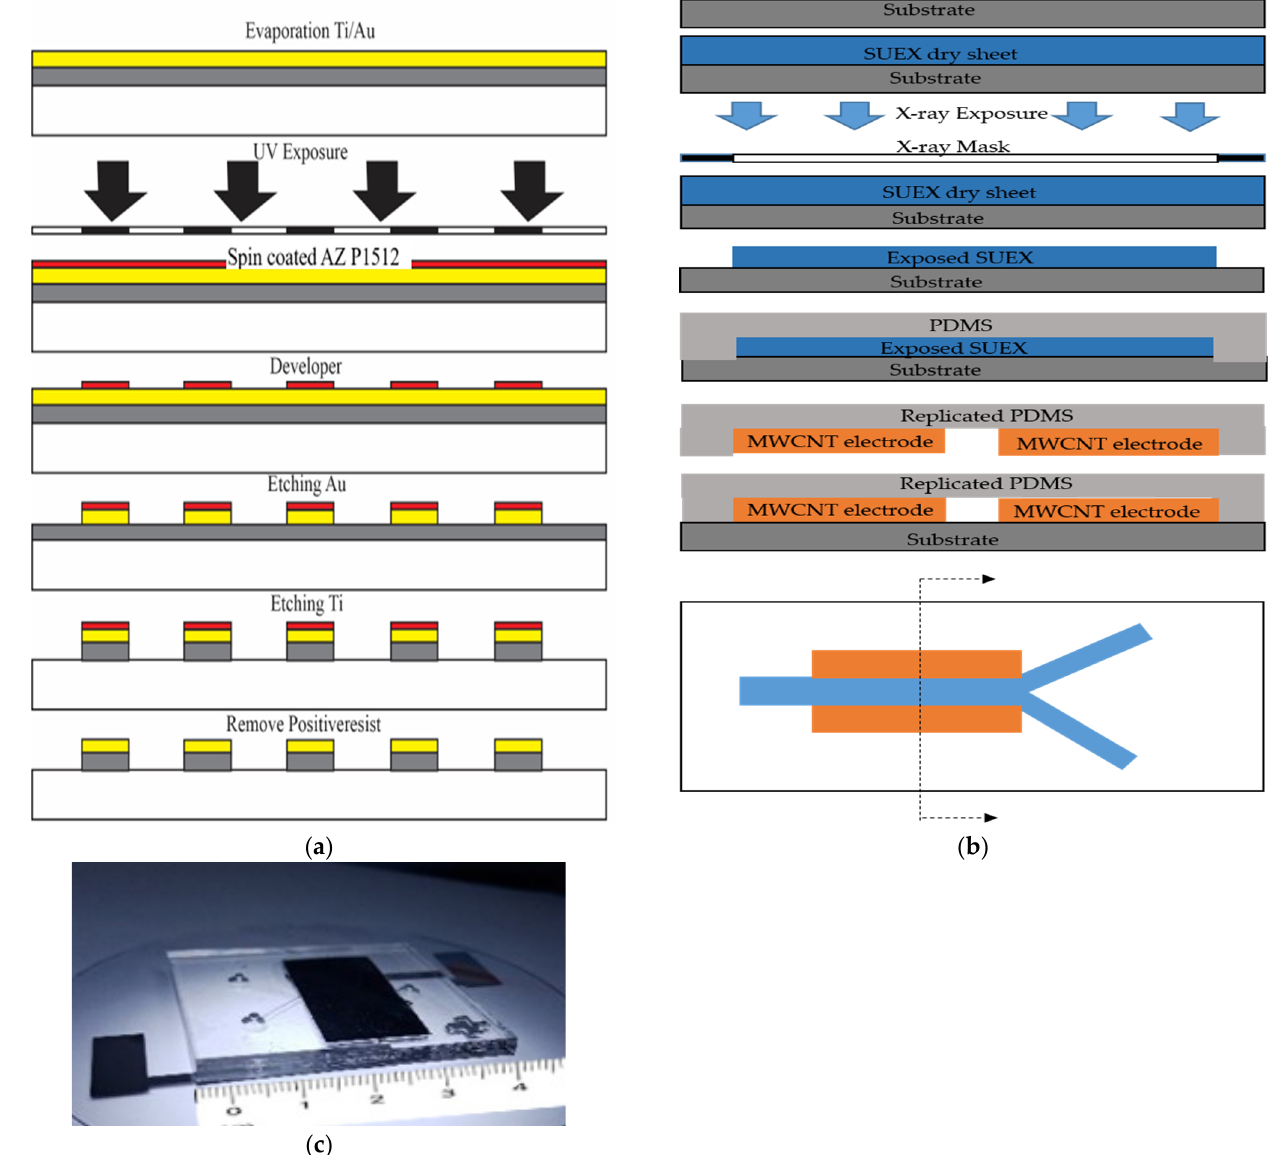
Figure 5. Illustration of the microfluidic device fabrication process using X-ray photolithography and soft lithography. ( a ) Fabrication of the microelectrodes ( b ) fabrication of the microchannels with MWCNT and ( c ) Microfluidic chip for MWCNT electrode. MWCNT and ( c ) Microfluidic chip for MWCNT